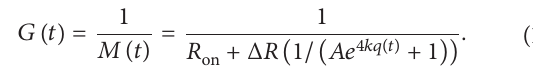
Figure 7: The relationship curve between the rate of the memristive conductance change and the